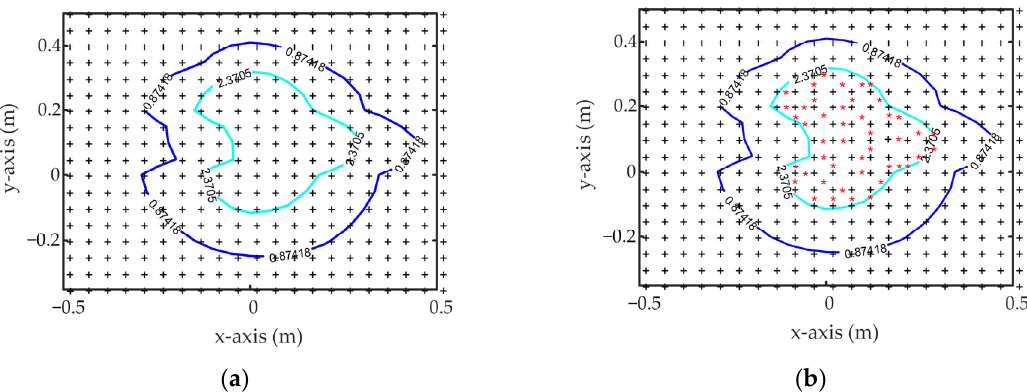
Figure 7. The distribution of measuring points. ( a ) Before the additional measurement; ( b ) After the additional measurement. additional measurement.